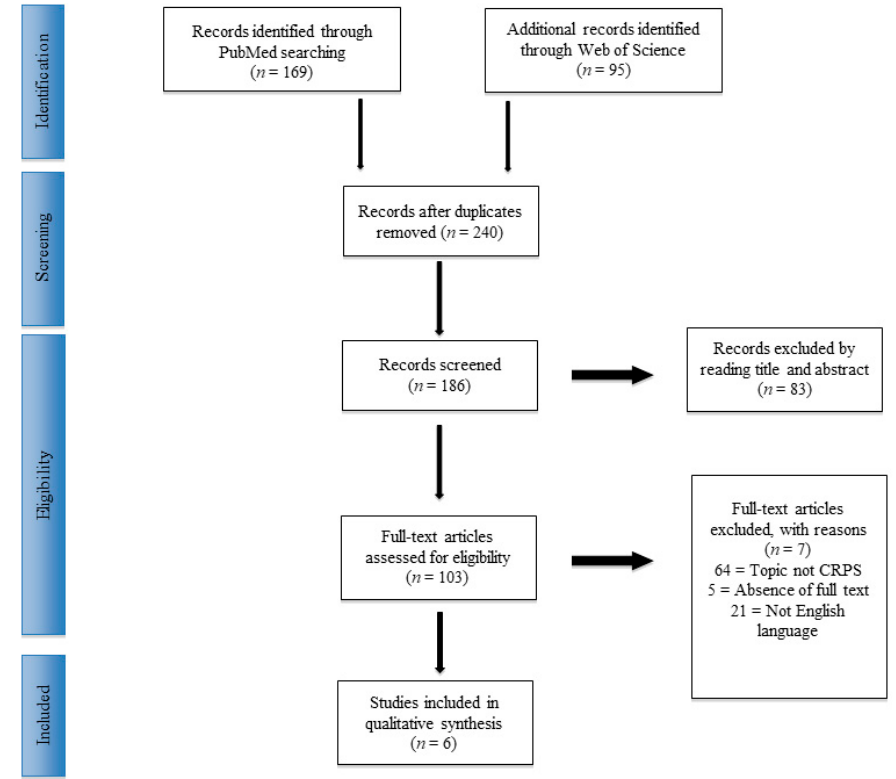
Figure 1. PRISMA (Preferred Reporting Items for Systematic Reviews and Meta-Analysis) flowchart of the systematic literature review .